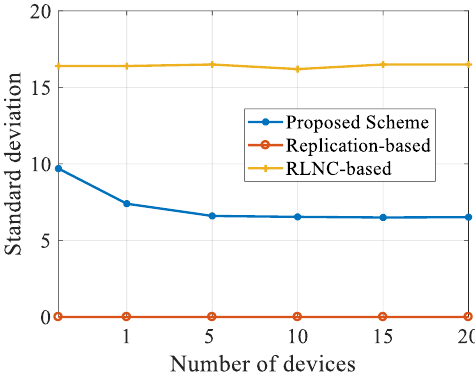
Figure 11. Analysis of load balance.